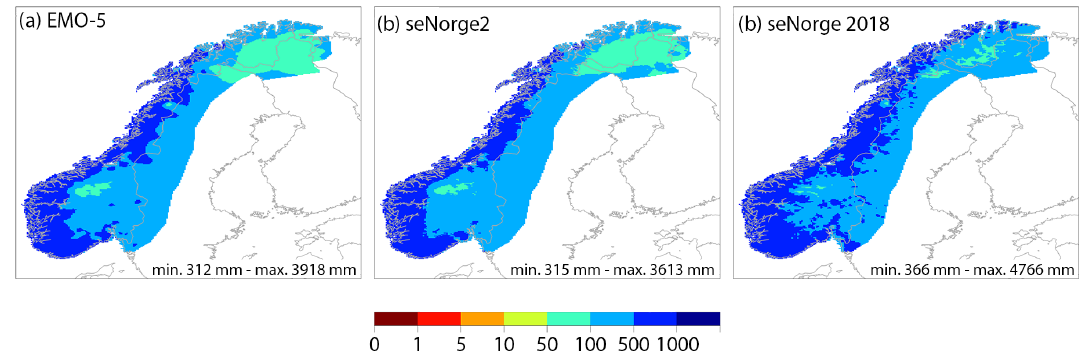
Figure 9. Mean annual precipitation [mm] for the (a) EMO-5, (b) seNorge2, and (c) seNorge2018 datasets for the joint period 1990–2015. The seNorge data are bi-linearly interpolated to the coarser EMO-5 resolution. EMO-5 was cropped to the same spatial extent as the seNorge datasets.